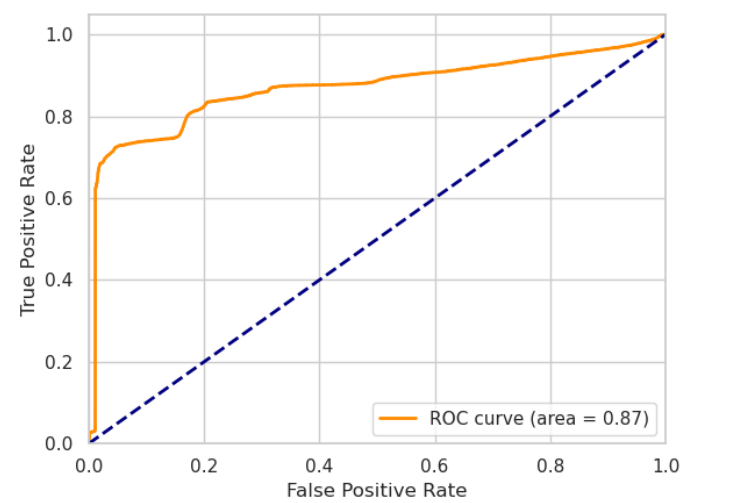
Figure 2. LW-LSTM-VAE-S (SWaT).